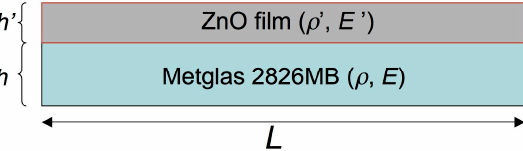
Figure 6. Schematic representation of the Metglas 2826MB and ZnO layers layout in our resonant